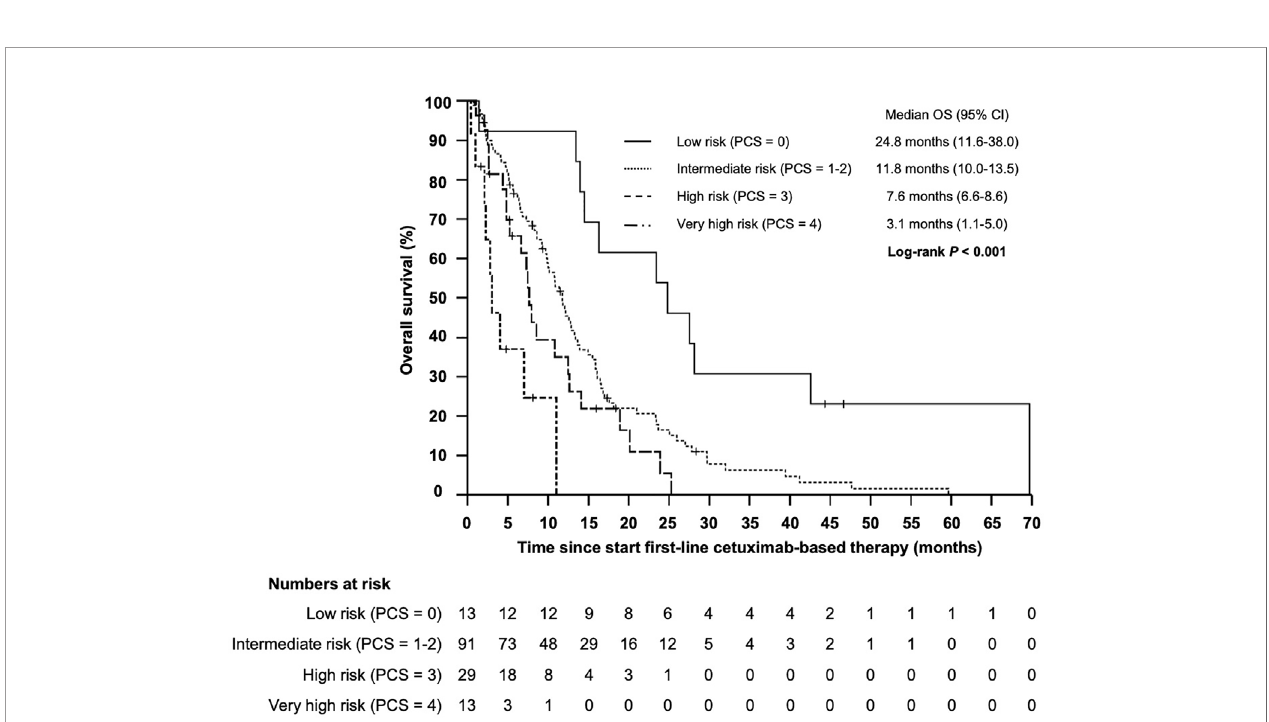
FIGURE 5 | Kaplan – Meier plot for overall survival (OS) according to the prognostic clinical score (PCS) from start of cetuximab-based fi rst-line therapy for low (PCS = 0 points), intermediate (PCS = 1 – 2 points), high (PCS = 3 points) and very high risk (PCS = 4 points) groups ( P < 0.001).